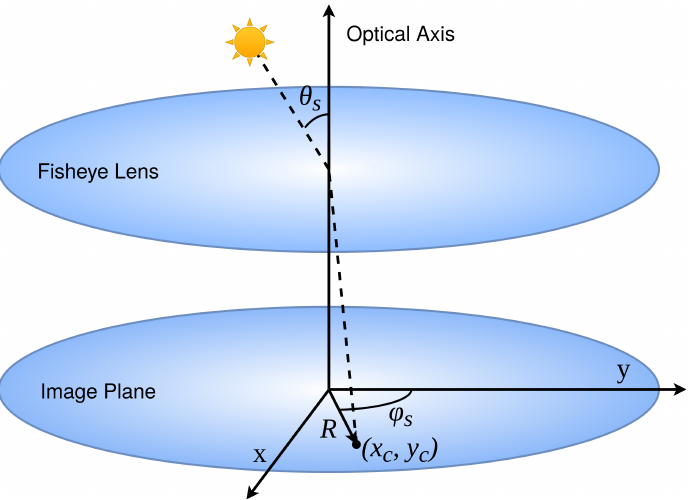
Figure 6. Overview of our sun localization approach on a sky image produced by fisheye lens.